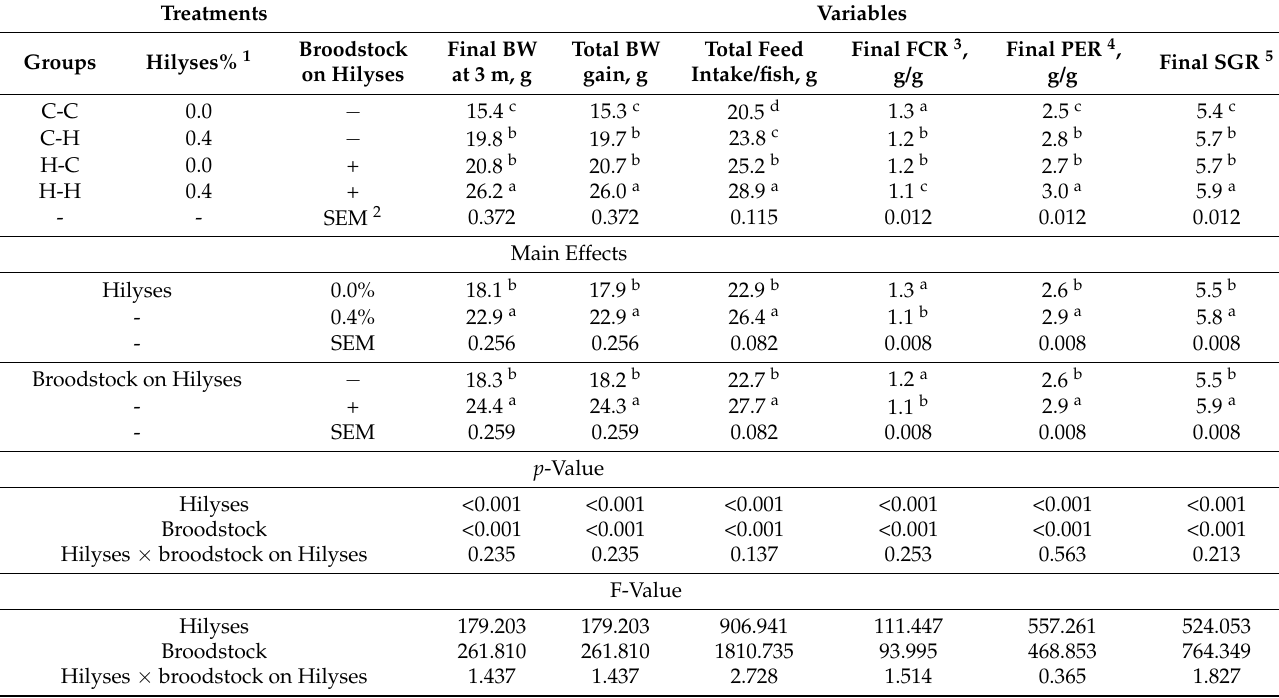
Table 6. Growth performance and feed utilization in Nile tilapia fry after three